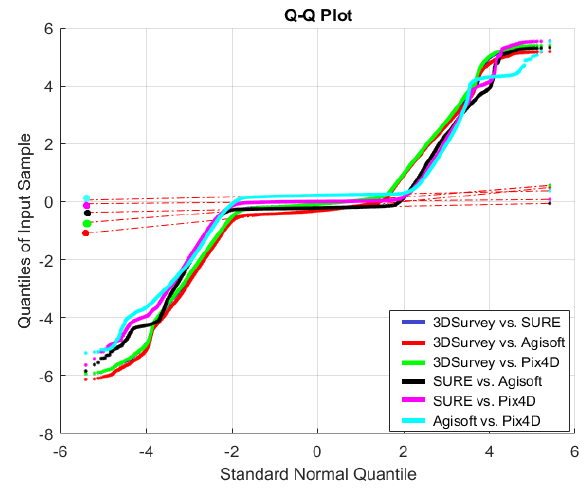
Figure 11. The Q-Q plots of height differences between two DSMs